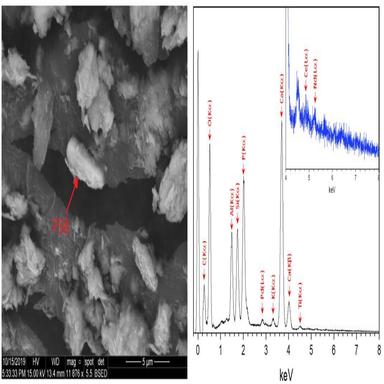
An apatite particle found in SP25-R2.